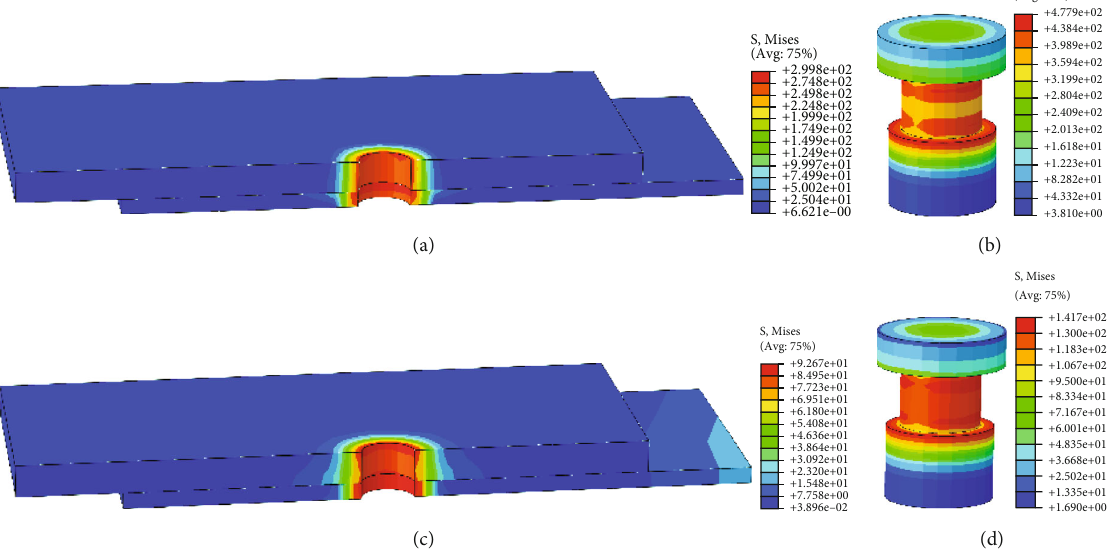
Figure 8: Mises stress contour map of the CMC and superalloy bolted joint with 1.2% clearance after applying preload and temperature but not tensile load. (a) CMC and superalloy plate at 20 ° C. (b)Bolt and nut at 20 ° C. (c) CMC and superalloy plate at 750 ° C. (d) Bolt and nut at 750 ° C.